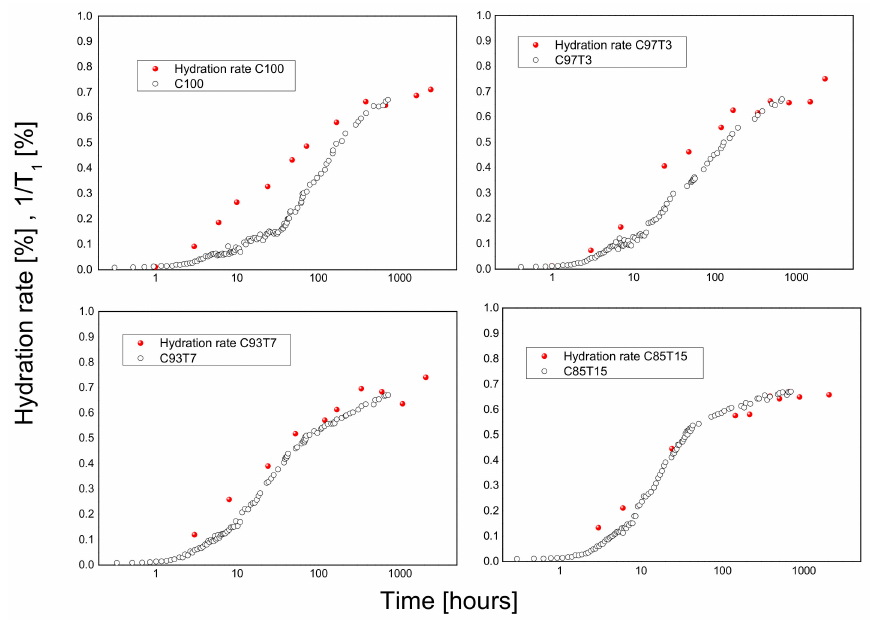
(cid:104) (cid:105) 1 versus hydration time for all T 1 norm